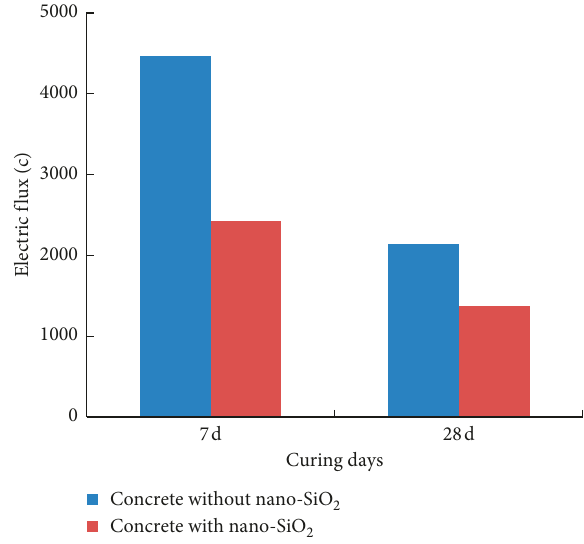
Figure 8: Electric flux test